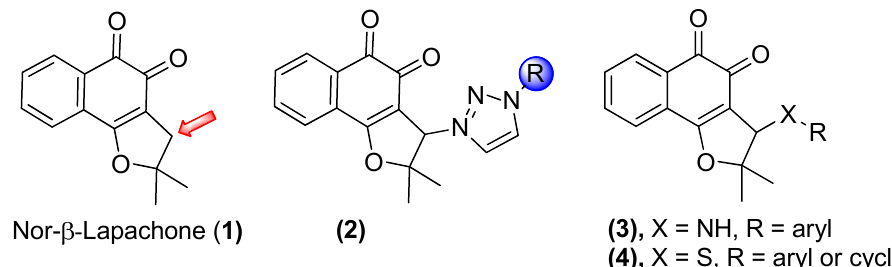
Figure 1. Bioactive nor- β -lapachone ( 1 ) and general structures of some derivatives.